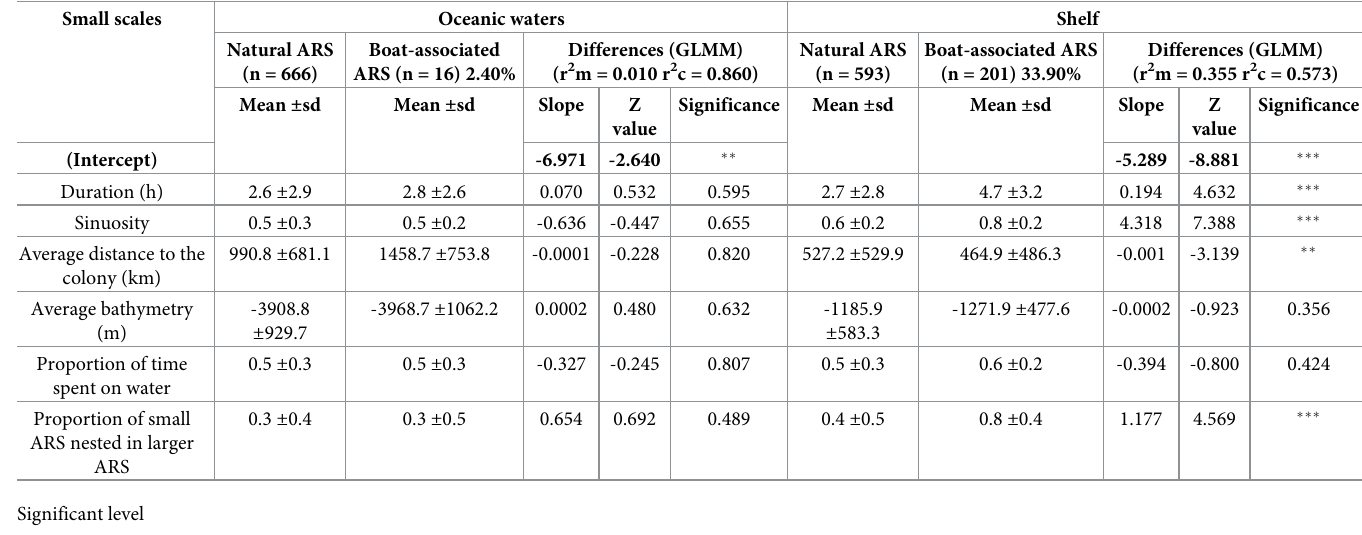
Table 2. Generalised linear mixed model results for differences between small scales in ocean waters /over shelf of natural ARS and boat-associated ARS. Small